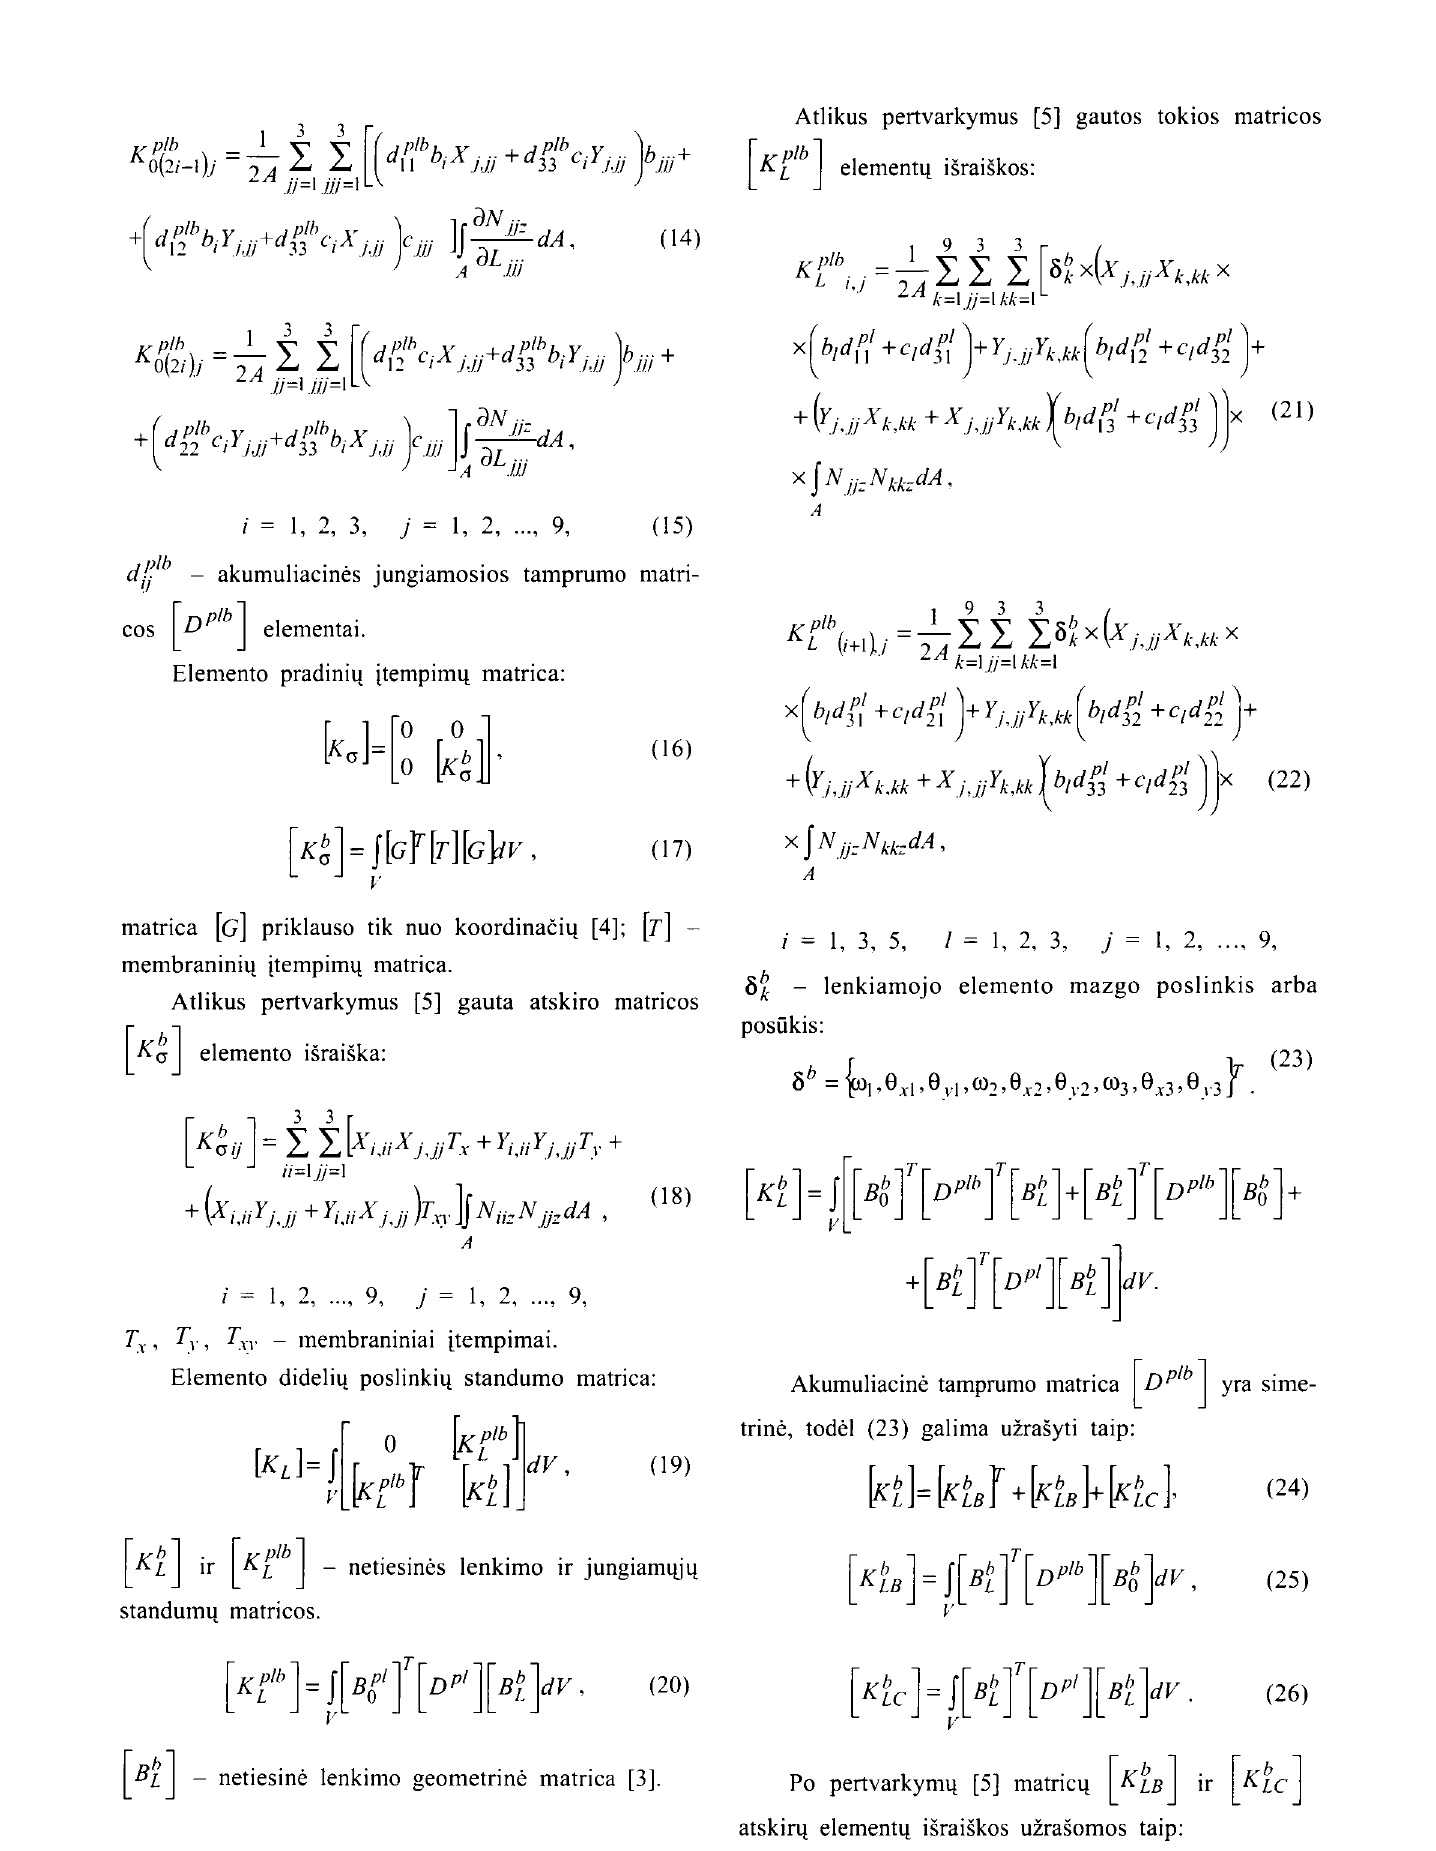
J f'b J - [ Kf ir [ K netiesines lenkimo ir jungiam~4 standum4